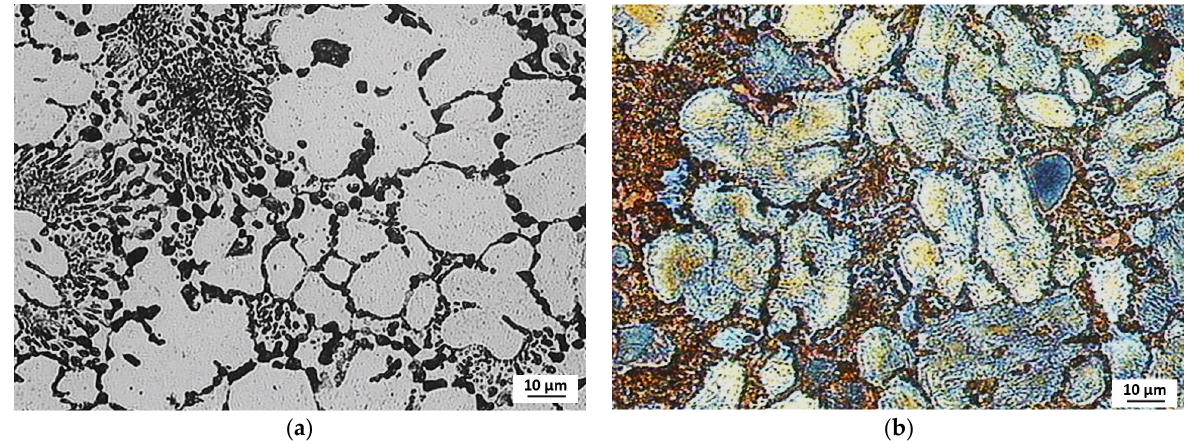
Figure 7. Microstructure of the ZnAl4Cu3 sample after first remelting (P1 alloy): ( a ) etched 0.5% HF and ( b ) etched Dix–Keller. and ( b ) etched Dix–Keller.